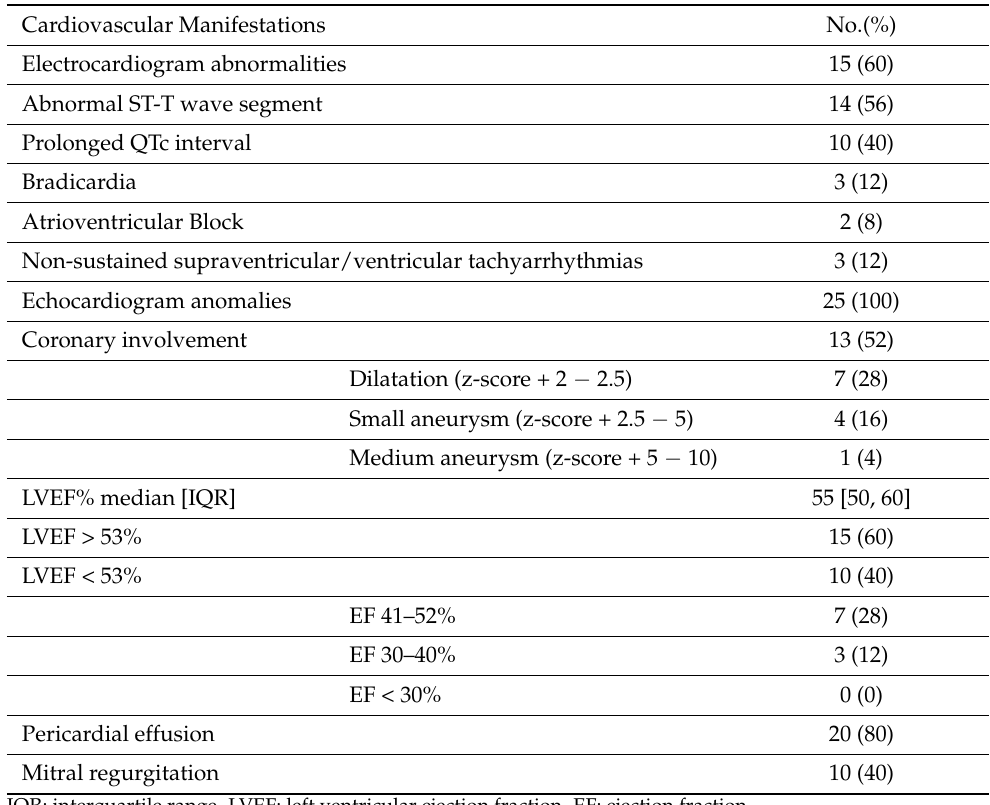
Table 3. Cardiovascular manifestations in the MIS-C cohort. MIS-C: multisystem inflammatory syndrome in children.